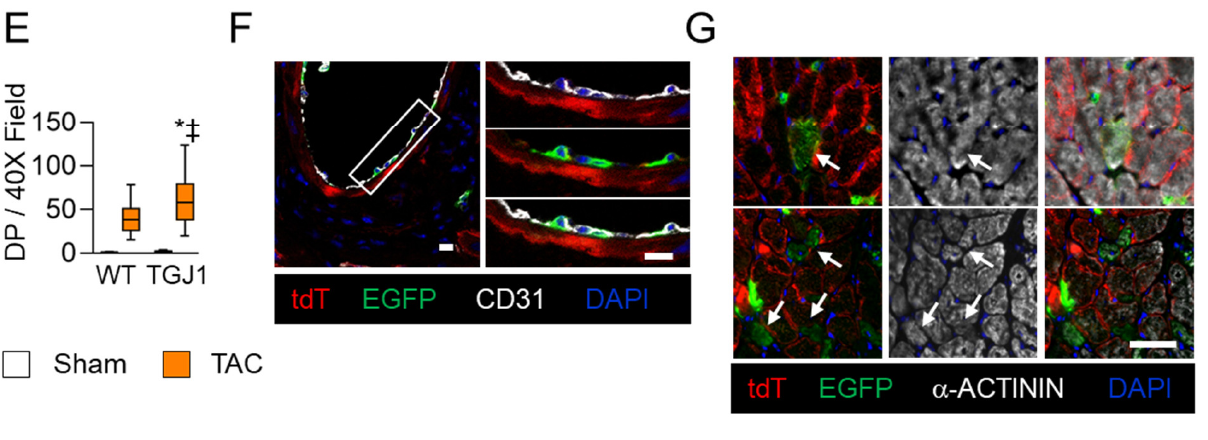
Figure 4. Fate of NOTCH1-activated cells in the stressed heart. ( A ) Experimental protocol. Wild type and TGJ1 mice harboring Notch1-IPCreErt2 and ROSA26-mTmG alleles were subjected to TAC or Sham operation. Mice were injected with Tamoxifen to induce tdT to EGFP conversion in cells experiencing NOTCH1 signaling in the 2 days before, the 2 days after and on the day of surgery. After 2 weeks, they were injected with α NRR1 antibody. Analysis was performed 4 weeks after operation. ( B ) Photomicrograph of heart tissue sections showing NOTCH1-traced EGFP+ cells in the myocardium of Sham and TAC-operated α NRR1-treated WT and TGJ1 mice. The graph on the right shows the number of EGFP+ cells per 40X microscope field. ( C ) Whole heart tissue section showing NOTCH1-traced cells. The insets marked ( a – d ) show NOTCH1-traced cells in the endocardium of the left and right ventricles ( a , b ), in a small blood vessel ( c ) and in the epicardium ( d ), which are indicated by asterisks. ( D ) Characterization of NOTCH1-traced EGFP+ cells. Tissue sections were stained with anti-EGFP (green) and with either anti-CD31, anti-PDGFR α , anti-PERIOSTIN or anti-GATA4 antibodies (Gray); non-traced cells express tdT (red). The graphs represent the percentage of double positive (% DP) EGFP+ cells expressing the indicated markers in WT and TGJ1 mice subjected to Sham or TAC surgery and α NRR1 treatment. ( E ) Number of CD31+-EGFP+ double-positive (DP) cells per 40X field in WT and TGJ1 mice subjected to Sham or TAC operation. ( F ) NOTCH1 traced cells in the endothelium of a large blood vessel. Heart tissue sections were stained for CD31 (Gray) and EGFP to reveal NOTCH1-traced cells. The insets show the area demarcated by the rectangle at high magnification. ( G ) Fluorescence micrographs showing NOTCH1-traced EGFP+ CMs (arrows), identified as single CMs or clusters of several CMs. The EGFP+ CMs (Green) also express α -actinin (Gray), as do the adjacent tdT+ CMs (Red). In ( B , D , E , F ), WT-Sham, n = 3; TGJ1-Sham, n = 4; WT-TAC, n = 6; TGJ1-TAC, n = 5. *, p < 0.05 in TAC vs. Sham; ‡, p < 0.05 in TGJ1 vs. WT. Scale bar